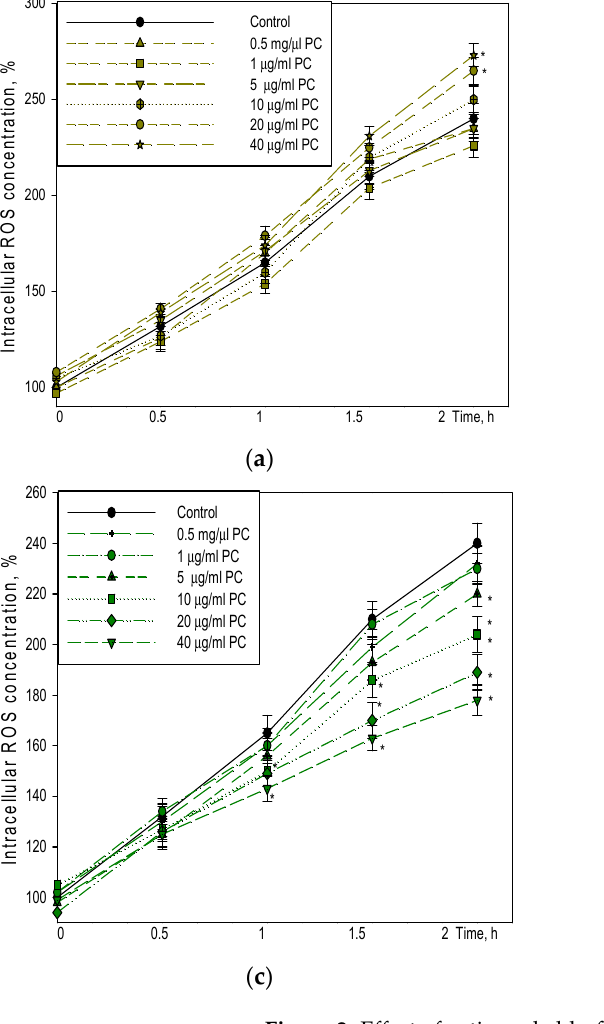
Figure 2. Effect of rutin and elderflower extracts on the intracellular level of ROS: ( a ) rutin; ( b ) WES extract; ( c ) Pg-WES extract; ( d ) EES extract. Cells were incubated for 30 min with 10 µM DCFH-DA in HBSS and with or without rutin or different extracts for 0, 0,5, 1, 1.5 and 2 h. For details, see the Materials and Methods section. * statistically significant difference vs. control. Missing error bars are smaller than the symbol size.